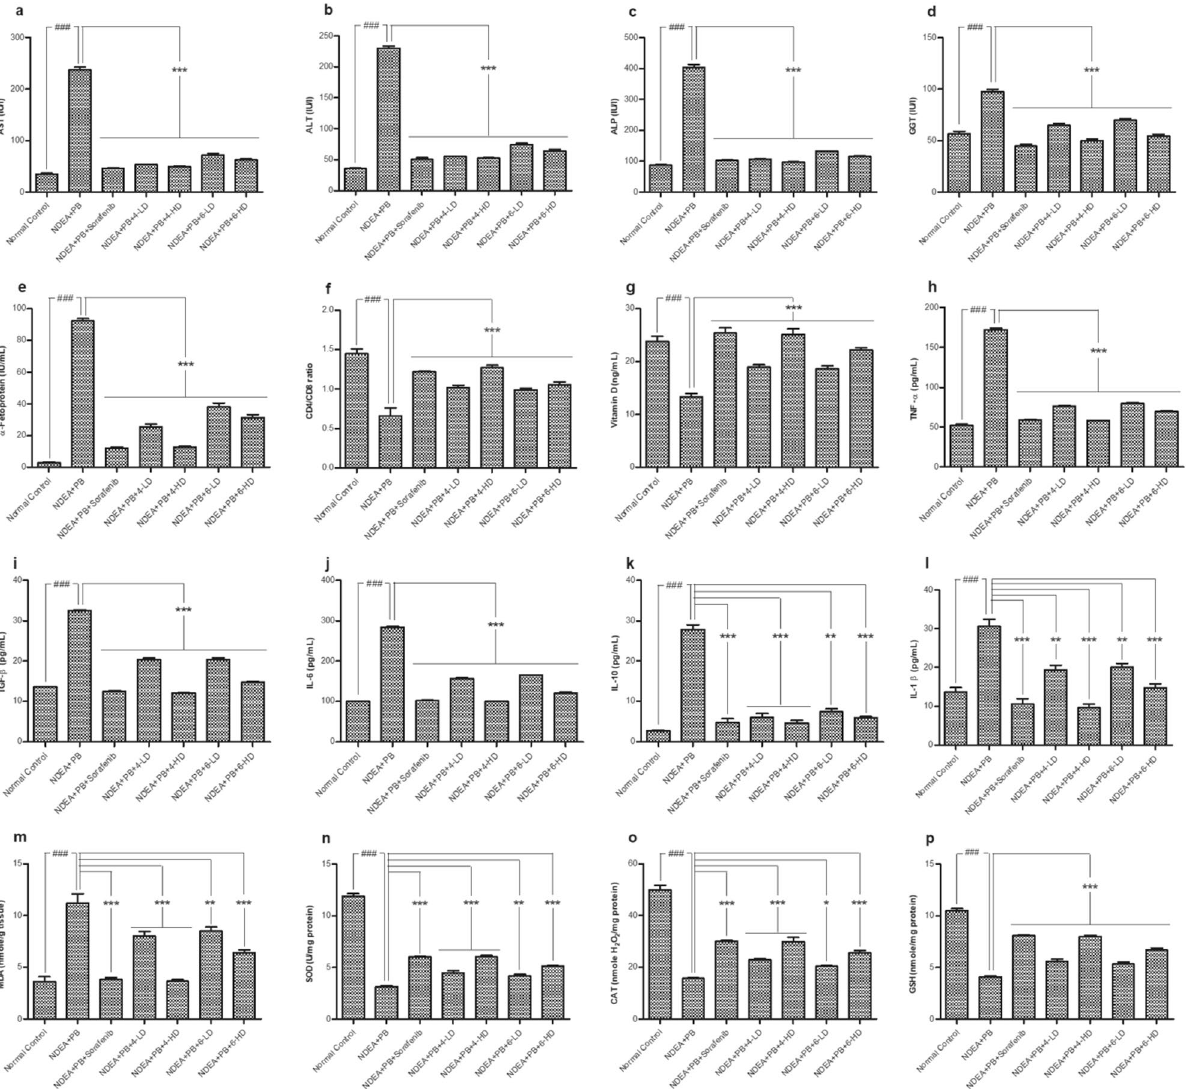
Figure 3. Effect of 4 and 6 on biochemical parameters of (NDEA + PB)-induced hepatocellular carcinoma in Sprague–Dawley rats. ( a ) Aspartate aminotransferase (AST) levels; ( b ) Alanine aminotransferase (ALT) levels; ( c ) Alkaline phosphatase (ALP) levels; ( d ) Gamma glutamyl transpeptidase (GGT) levels; ( e ) α-Fetoprotein; ( f ) CD4/CD8 ratio; ( g ) Vitamin D; ( h ) Tumor necrosis factor-α (TNF-α); ( i ) Tissue growth factor-β (TGF-β); ( j ) Interleukin-6 (IL-6); ( k ) Interleukin-10 (IL-10); ( l ) Interleukin-1 β (IL-1β); ( m ) Malondialdehyde (MDA); ( n ) Superoxide dismutase (SOD); ( o ) Catalase (CAT); ( p ) Glutathion reductase (GSH). All the values were expressed as mean ± standard error of the mean where n = 10 animals. The data were analyzed by one-way analysis of variances, followed by Tukey’s test, where * P < 0.05, ** P < 0.01, and *** P < 0.001 statistically significant when compared with the disease control, and ### P < 0.001 statistically significant when compared with normal control. The values in the parentheses indicate the percentage protection. NDEA: N -nitrosodiethylamine (200 mg/kg); PB: phenobarbital sodium (500 parts per million). Sorafenib: 30 mg/kg; 4-/6- LD: 5 mg/kg; 4-/6- HD: 10 inflammatory proteins in the disease control as compared to the normal control group, with fold changes for the levels of TNF-α, TGF-β, IL-6, IL-10, and IL-1 noted to be approximately 3.3, 2.4, 2.9, 9.9, and 2.3, respec- tively (Fig. 3h–l). However, these changes were also significantly reversed by administration of compound 4 or 6 . Among all the tested conditions, 4- HD also showed to be the most potent in reversing the negative effects caused by (NDEA + PB) and brought the levels of all five pro-inflammatory proteins to a level similar to that of the standard and normal control groups (Fig. 3h–l). Lipid peroxidation (malondialdehyde, MDA) and antioxidant levels were significantly ( P < 0.001) altered in the disease control as compared to the normal control group (Fig. 3m). Specifically, MDA was increased > three- fold while the antioxidants catalase (CAT), superoxide dismutase (SOD), and reduced glutathione (GSH) were decreased ~ 3.8-, 3.2-, and 2.6-fold in the disease control versus normal control rats (Fig. 3m–p). Interestingly,